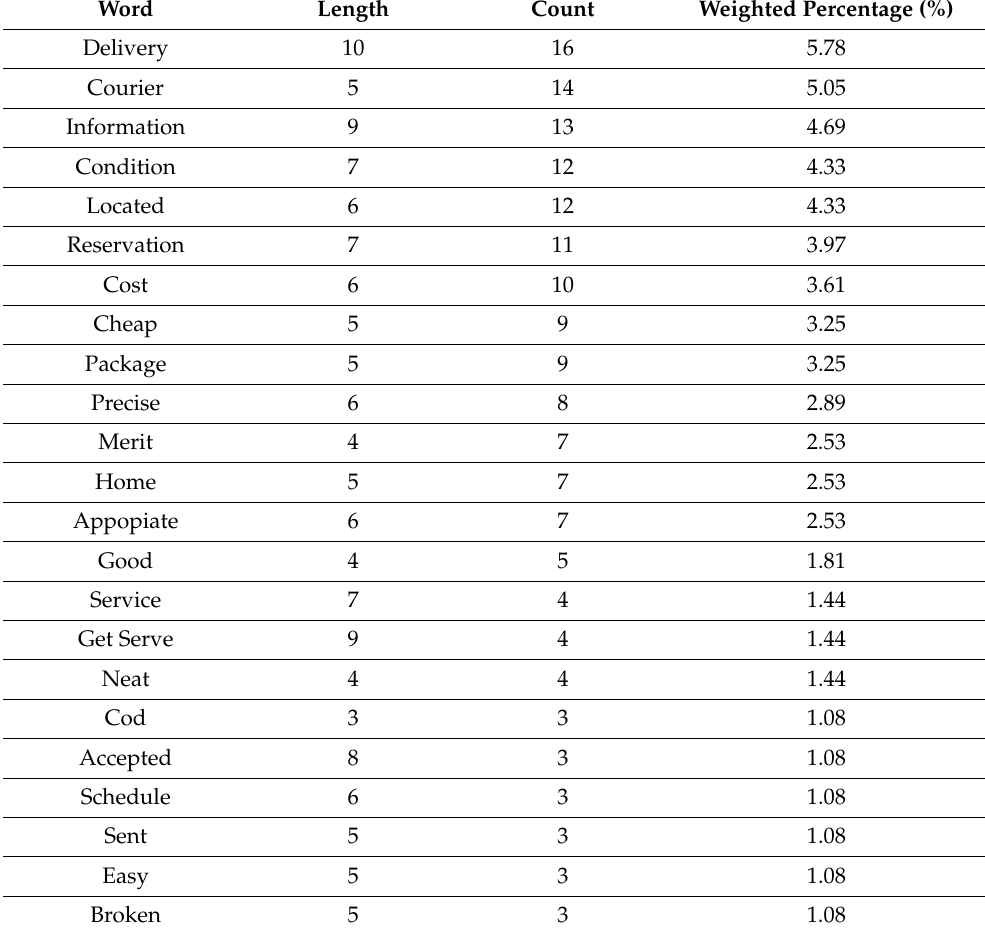
Table 2. Recapitulation of attributes